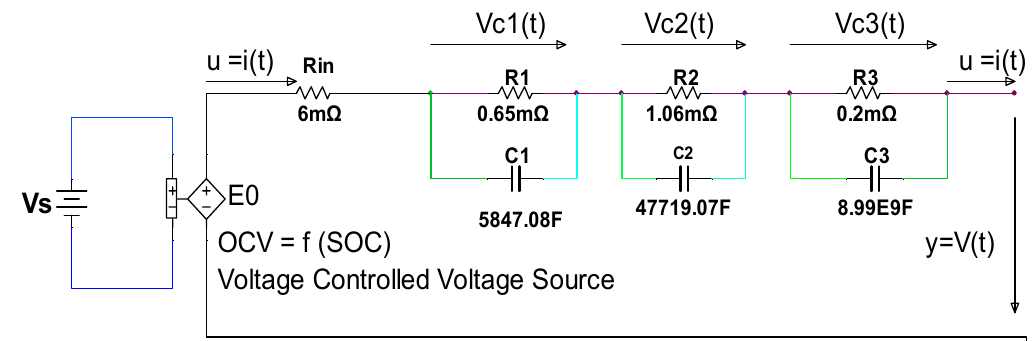
Figure 6. The third order 3RC electric circuit model (ECM)–Li-Ion battery represented in NI Multisim 14.1 editor (see [19]).